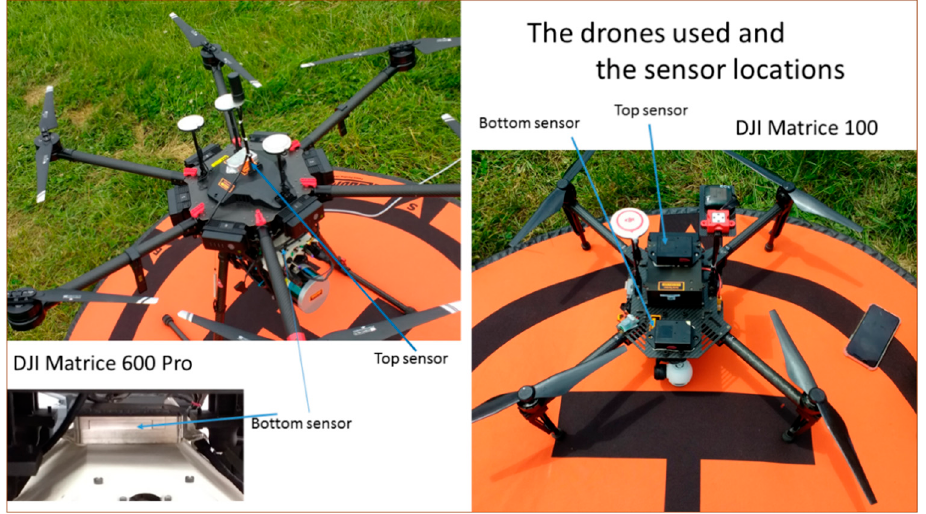
Table 1. Specification of the DJI Matrice drones.